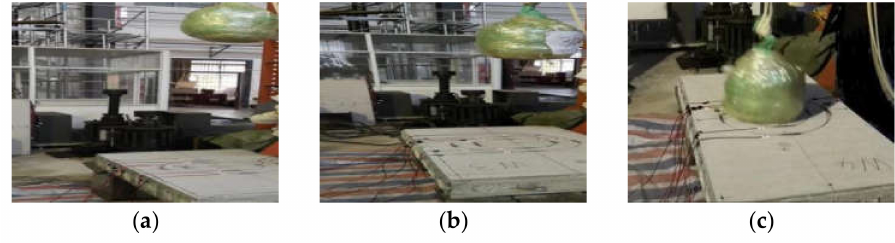
Figure 9. Test process diagram of W2, W3 and W4. ( a ) W2; ( b ) W3; ( c ) W4.